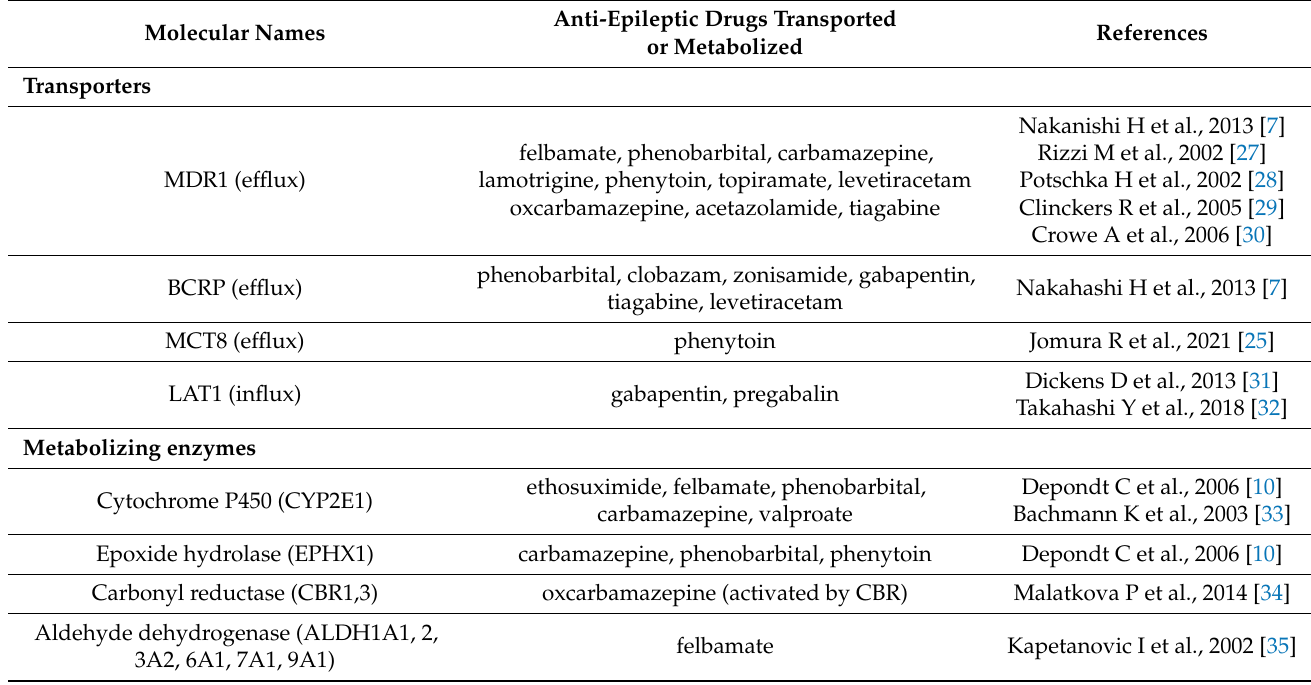
Table 2. Detected transporters and metabolizing enzymes which transport and metabolize anti-epileptic drugs. Molecular